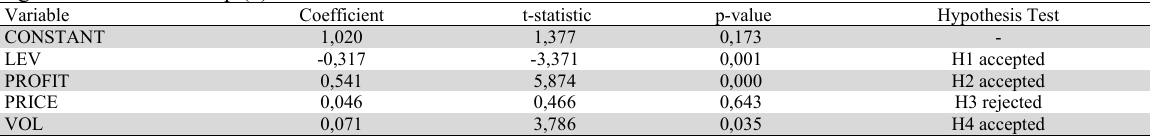
Regression results for Eq. (1).